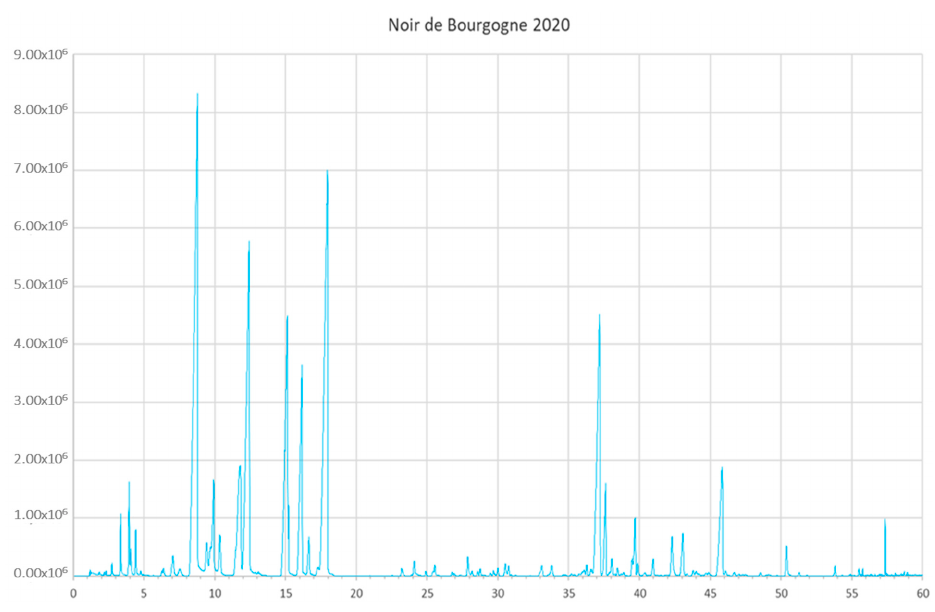
Figure A1. Example of chromatogram obtained for Noir de Bourgogne. Table A1. Retention time, retention index, and mean values of the relative concentration of three replications for the 20 molecules followed in all parental cultivars.